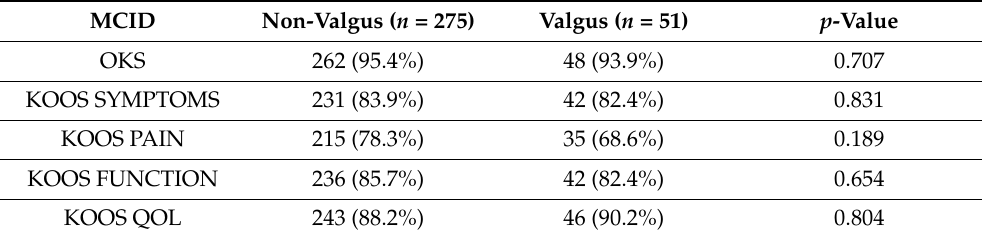
Figure 2. Mean (and SD) patient reported outcome scores in the valgus (green columns) versus non-valgus (blue columns) groups; (KOOS) Knee injury and Osteoarthritis Outcome Score; (OKS) Oxford Knee Score; (VAS) Visual Analog Scale; (QOL) Quality of Life. Table 3. Number and percentage of patients achieving minimal clinical differences (MCID) of the oxford knee score (OKS) and the Knee injury and Osteoarthritis Outcome Score (KOOS) sub-categories in the valgus versus non-valgus groups.